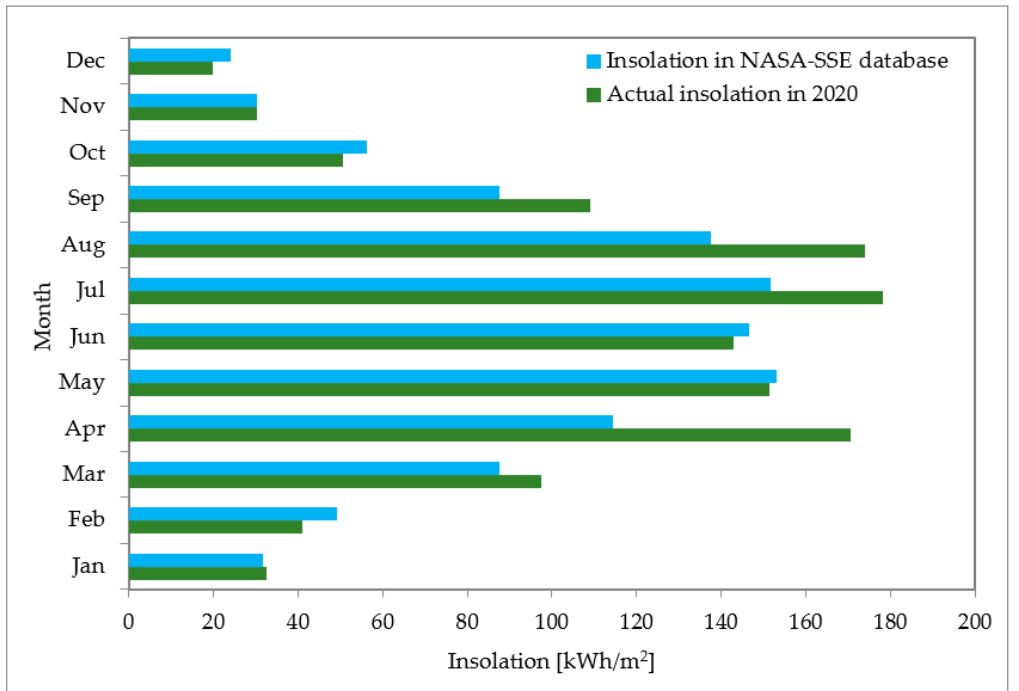
Figure 14. Insolation measured by SolarAOT and NASA-SSE database.